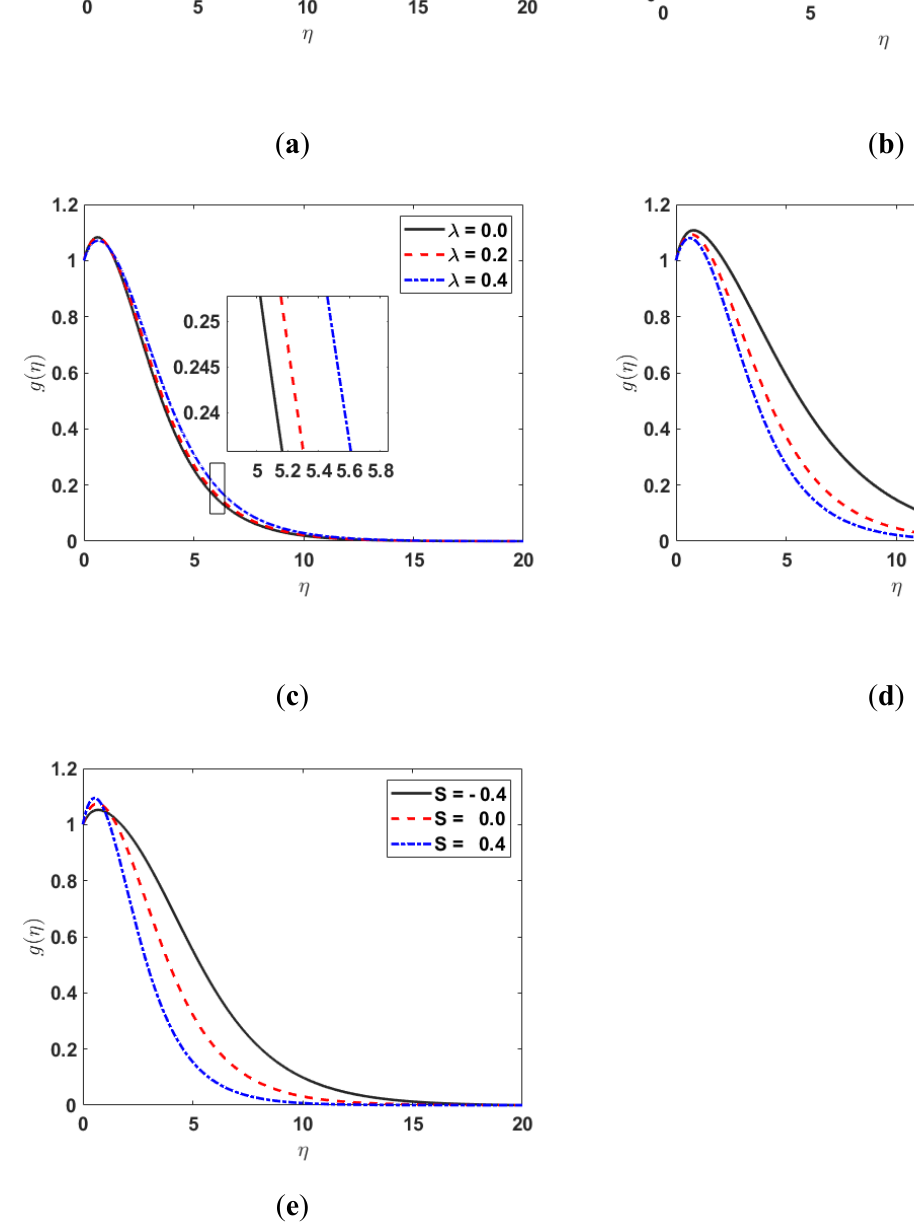
Figure 6. ( a ) g ( η ) along Y; ( b ) g ( η ) along M ; ( c ) g ( η ) along λ ; ( d ) g ( η ) along Gr ; ( e ) g ( η ) along S Figure 6. ( a ) 𝑔(cid:4666)𝜂(cid:4667) along Υ ; ( b ) 𝑔(cid:4666)𝜂(cid:4667) along 𝑀 ; ( c ) 𝑔(cid:4666)𝜂(cid:4667) along 𝜆 ; ( d ) 𝑔(cid:4666)𝜂(cid:4667) along 𝐺𝑟 ; ( e ) 𝑔(cid:4666)𝜂(cid:4667) along 𝑆 .